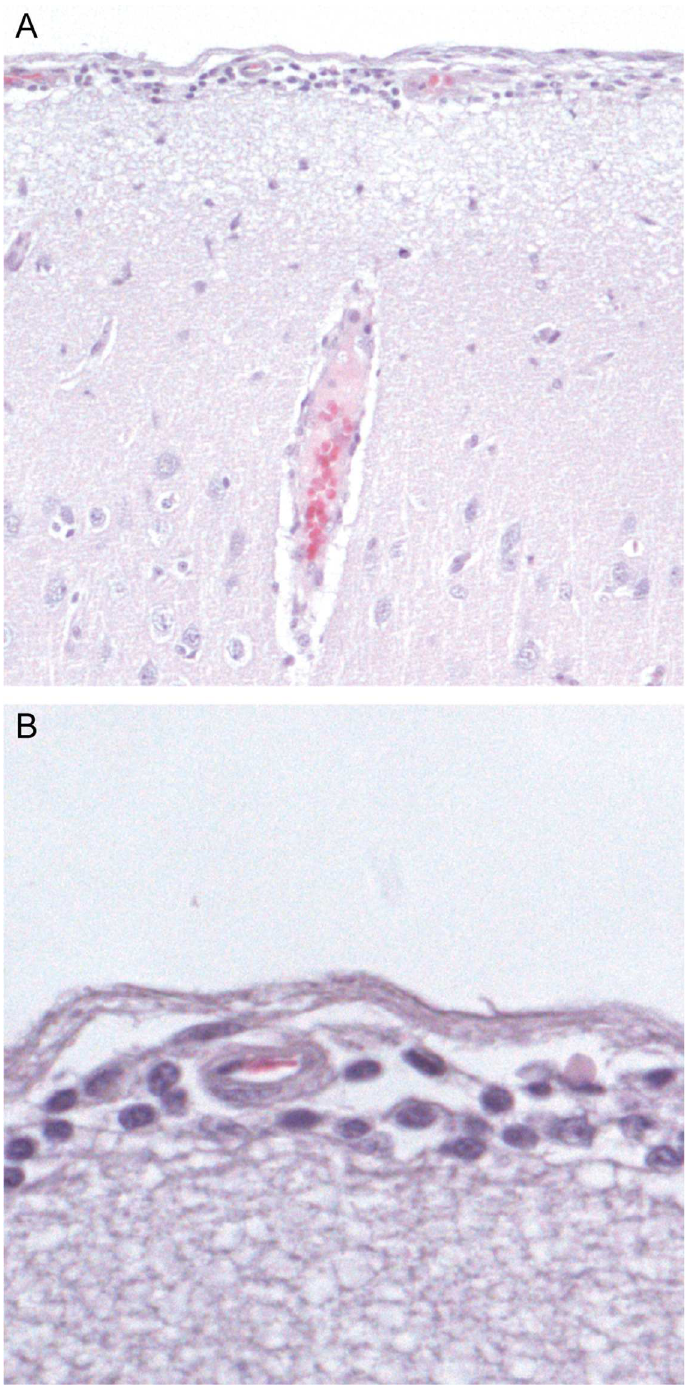
Fig 1. Inflammation in the meninges and brain parenchyma of a bat with Lagos bat virus infection (bat 10, Ghana strain). H & E staining. Original magnification: x10 ( A ), x40 ( B ) A : Perivascular cuffing surrounding blood vessels in the meninges. Cells surrounding blood vessels are mainly composed of small mononuclear cells with dense chromatin pattern (lymphocytes). B : Higher magnification of A .